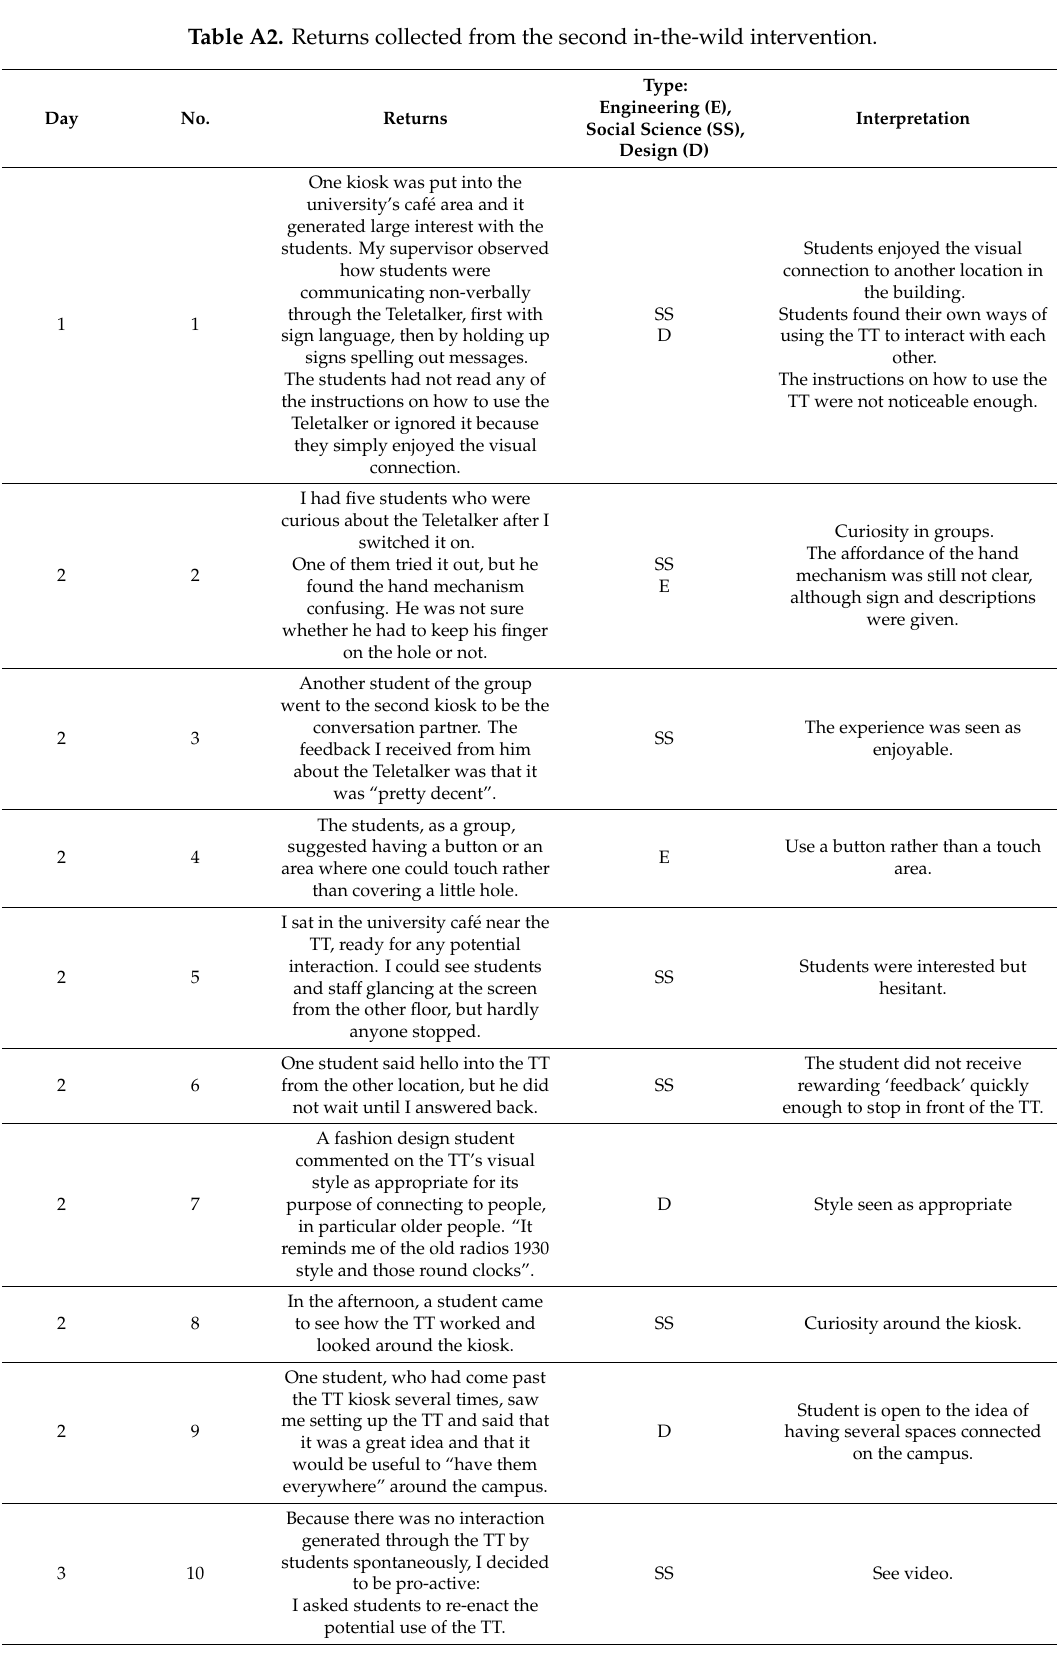
Table A2. Returns collected from the second in-the-wild intervention.